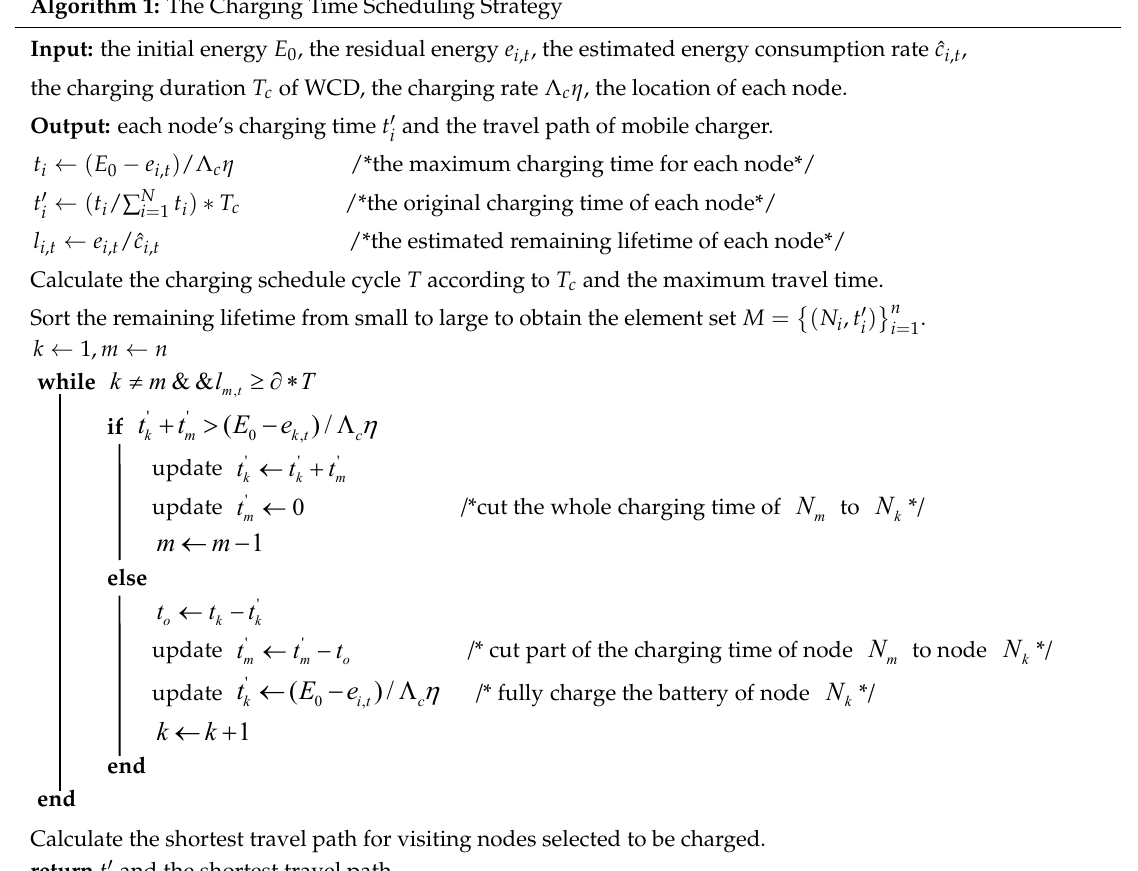
Algorithm 1: The Charging Time Scheduling Strategy